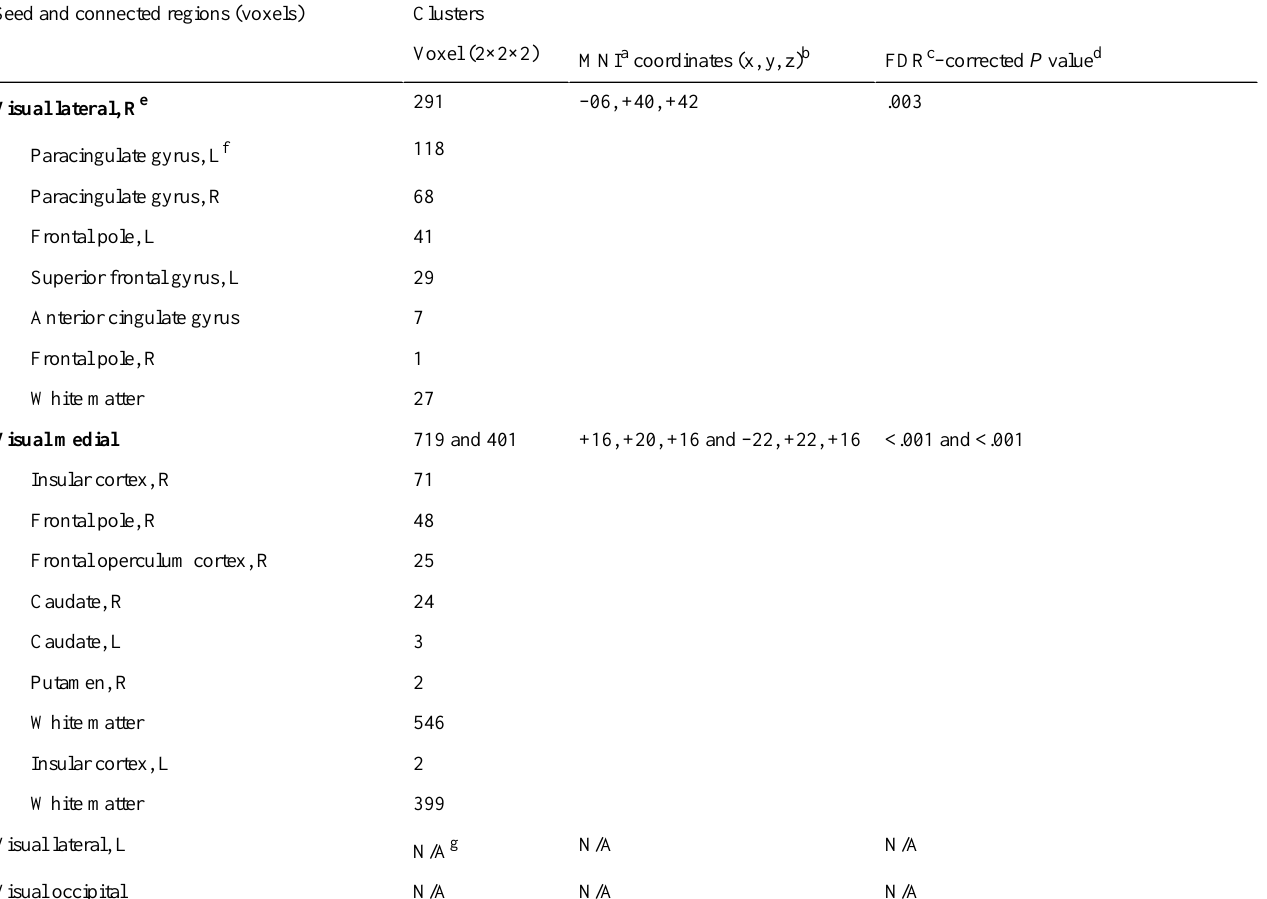
Table 6. Functional visual network connectivity related to improved Rey-Osterrieth Complex Figure Test copy task scores after virtual reality cognitive